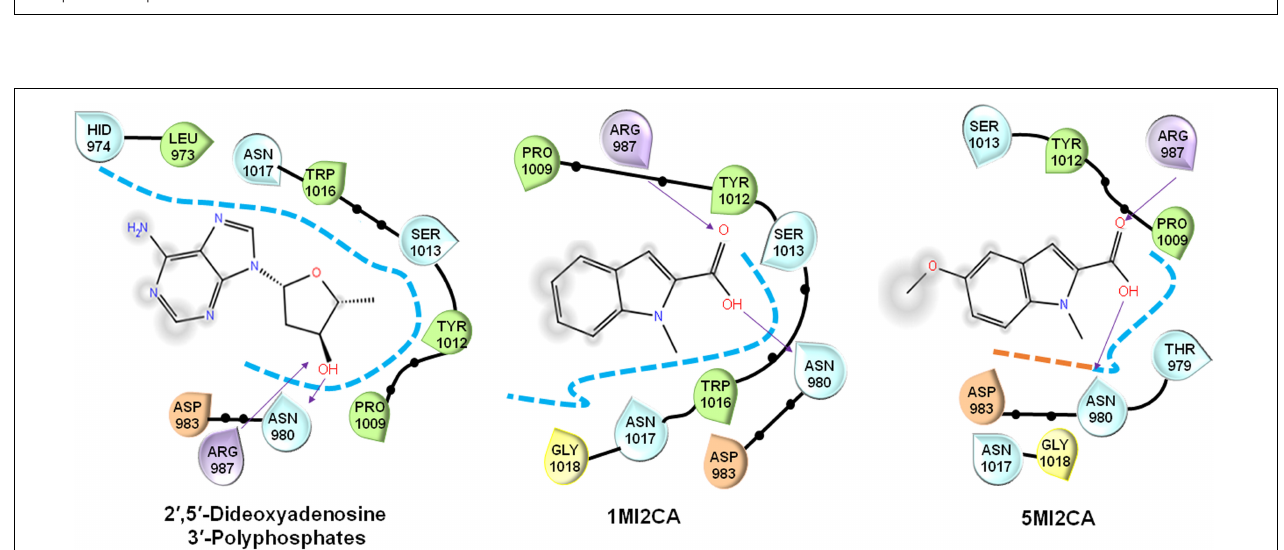
FIGURE 5 | Molecular docking of the interaction between 1MI2CA or 5MI2CA and adenylate cyclase. The binding orientations of 1MI2CA and 5MI2CA within the active site of adenylate cyclase were similar to that of 2 (cid:48) ,5 (cid:48) -dideoxyadenosine 3 (cid:48) -polyphosphate as a positive control.